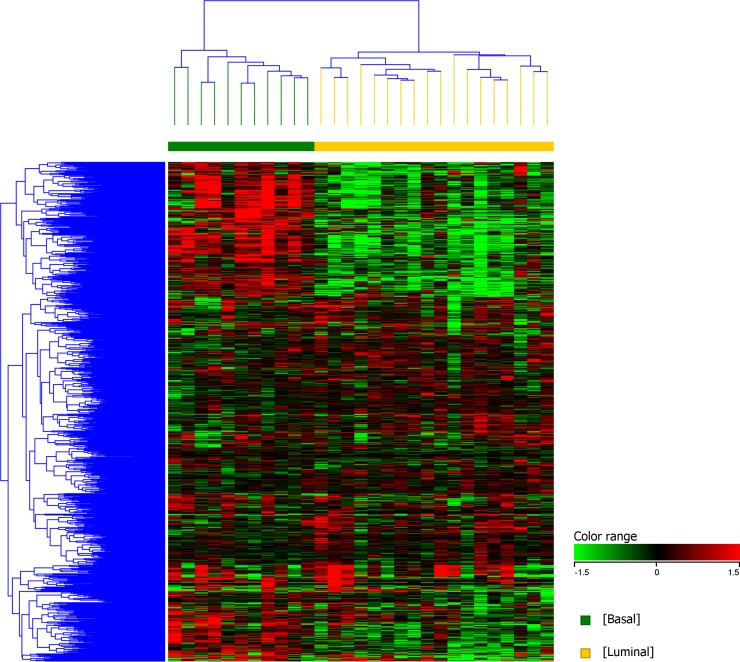
Unsupervised hierarchical clustering of genes identifying basal and luminal subtypes in canine iUC samples.Genes that assign basal and luminal subtypes in human breast cancer (and confirmed in human iUC) [6] were used to query the differentially expressed genes identified in canine iUC samples, and 829 commonly expressed genes were identified. Unsupervised hierarchical clustering was performed using these 829 genes employing Euclidean distance metrics and Ward’s linkage algorithm as a distance metric. Two distinct groups were identified as basal (n = 11) and luminal (n = 18).